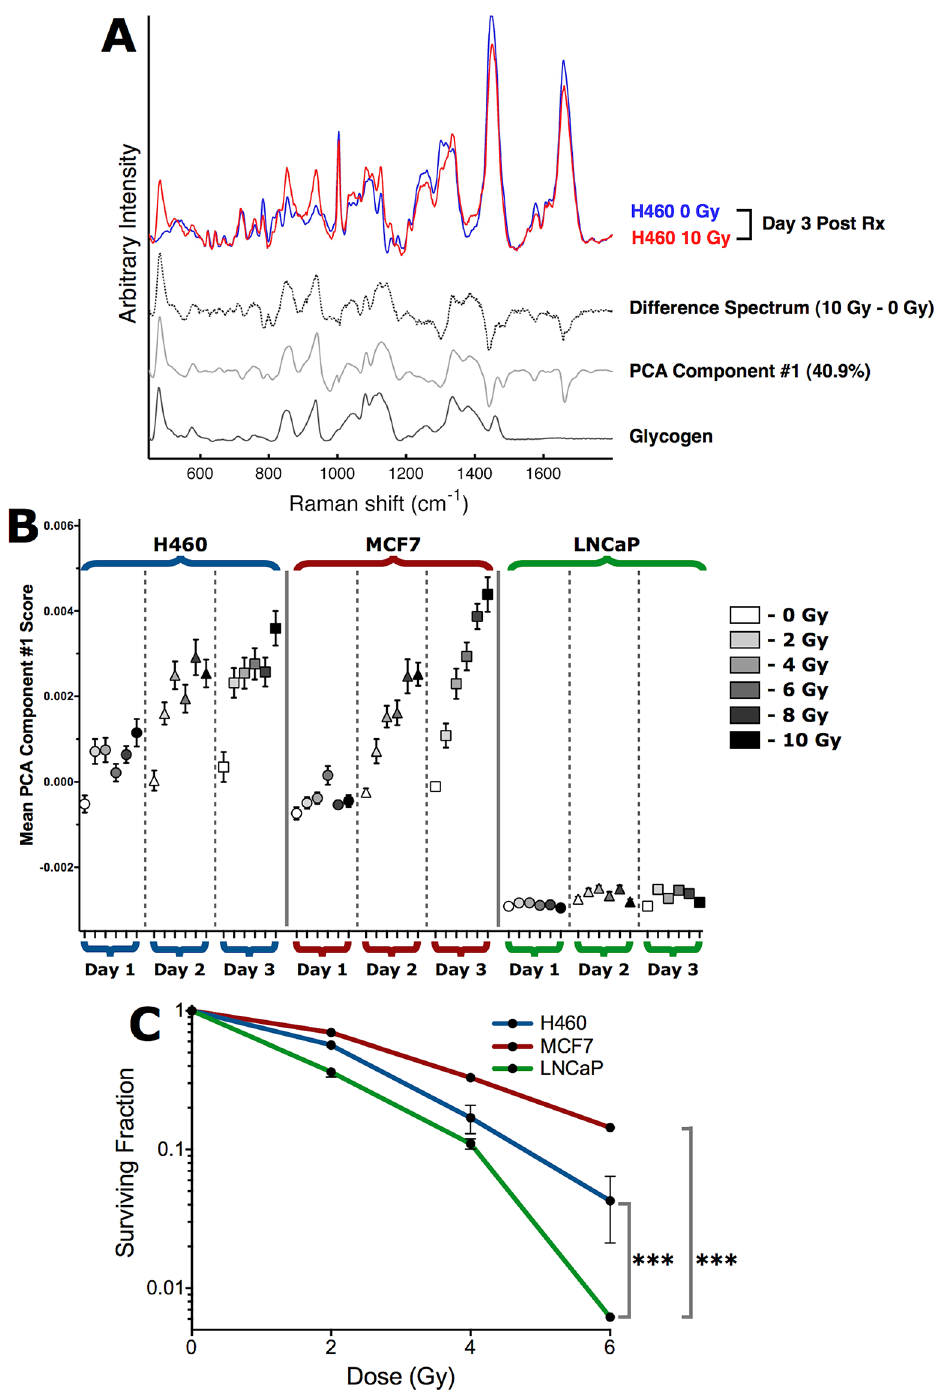
Fig 1. Single-cell Raman spectroscopy with PCA detects early radiation-induced glycogen synthesis in H460 and MCF7 cells, but not in radiosensitive LNCaP cells. (A) Single-cell Raman spectra of an irradiated H460 cell (10 Gy) and an unirradiated H460 cell at 3 days post-irradiation demonstrate the Raman spectroscopic detection of increased intracellular glycogen in irradiated H460 and MCF7 cells. The difference spectrum (dashed trace) is shown for comparison with the first PCA component (solid gray trace) from the entire Raman spectroscopy data set presented in B. The Raman spectrum of glycogen (black trace) is shown for comparison. (B) H460, MCF7 and LNCaP cells were irradiated with single fractions of radiation, and single-cell Raman spectra were collected from 20 cells from each sample post-irradiation. Experiments